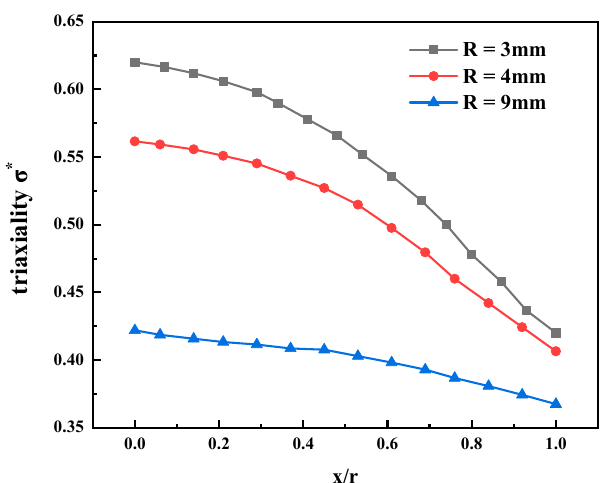
Figure 9. Distributions of stress triaxiality at the minimum section of notched round bar specimens with different notch radii. Table 3. Facture strain and stress triaxiality of